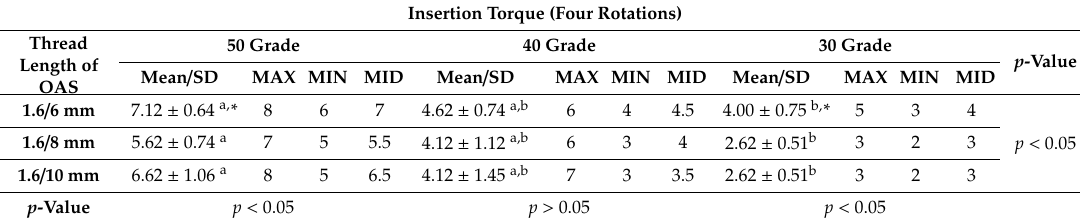
Table 3. Insertion torque values (four rotations) measured using the manual anchorage method. Insertion Torque (Four